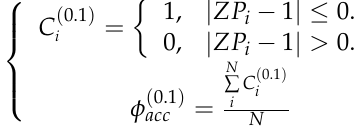
Figure 6. Rolling force qualification rate of each stand. 4.1.2. After Optimization of the Friction Coefficient Model As shown in Figure 7, the distribution of the calculated rolling force has three obvious characteristics after optimizing μ 0 : (1) The maximum and minimum values of ZP have changed. Taking S2 as an example, the maximum and minimum ZP values before optimization are 1.2172 and